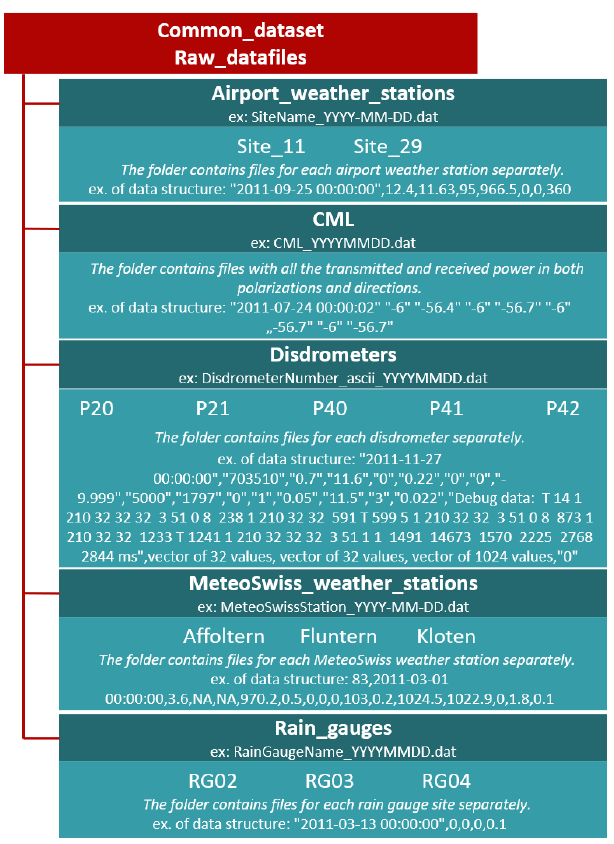
Figure 6. The organization scheme of the files in folders.